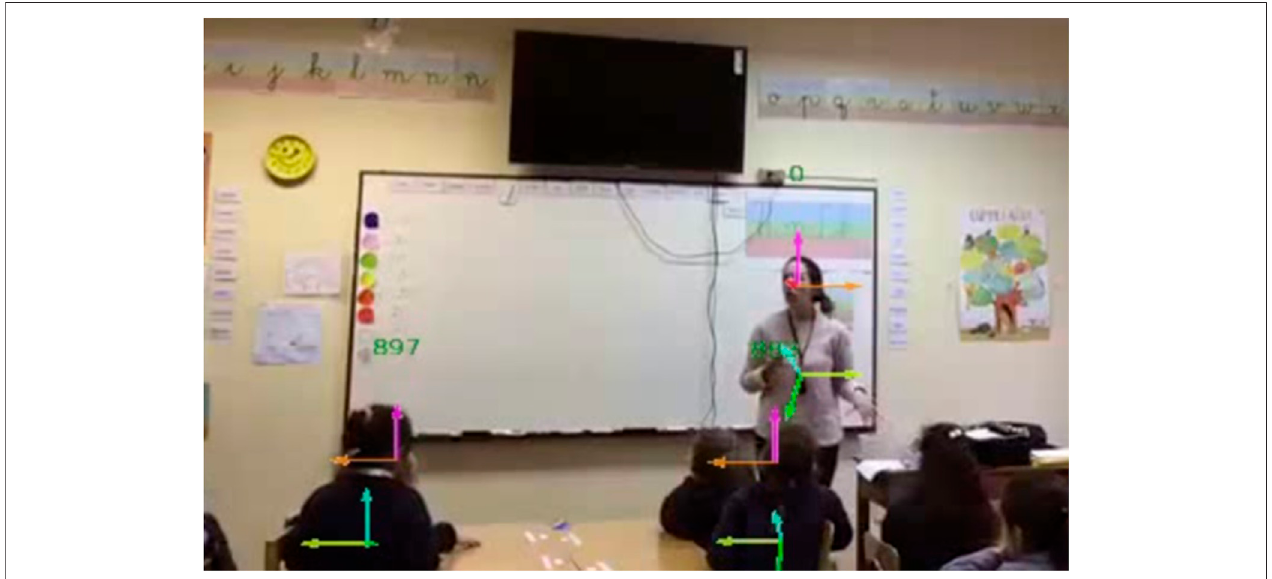
FIGURE 5 | Screenshot of the output of one estimator for the teacher gaze and body orientation, and for some of the students. The numbers are identi fi ers of the subjects.